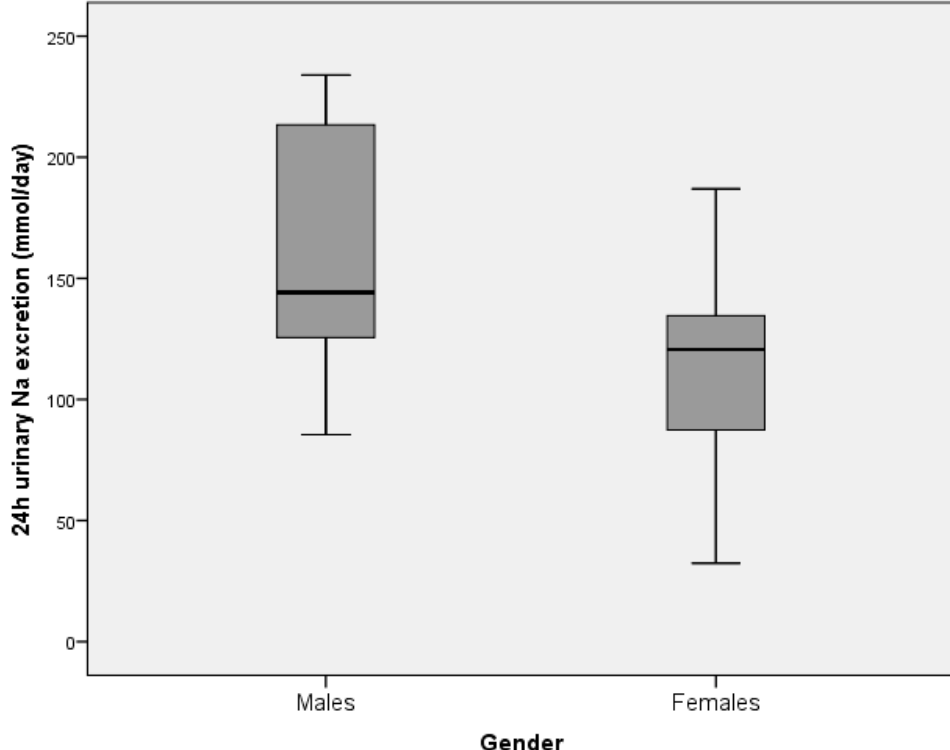
Figure 3. The estimate of mean urinary sodium excretion (over 24 h) in residents of retirement homes in the Goriška region, presented by gender (males: N = 17, females: N = 30). Boxes indicate medians (line inside box) and quartiles (upper and lower margins of the boxes); 95% CI are represented by vertical lines.